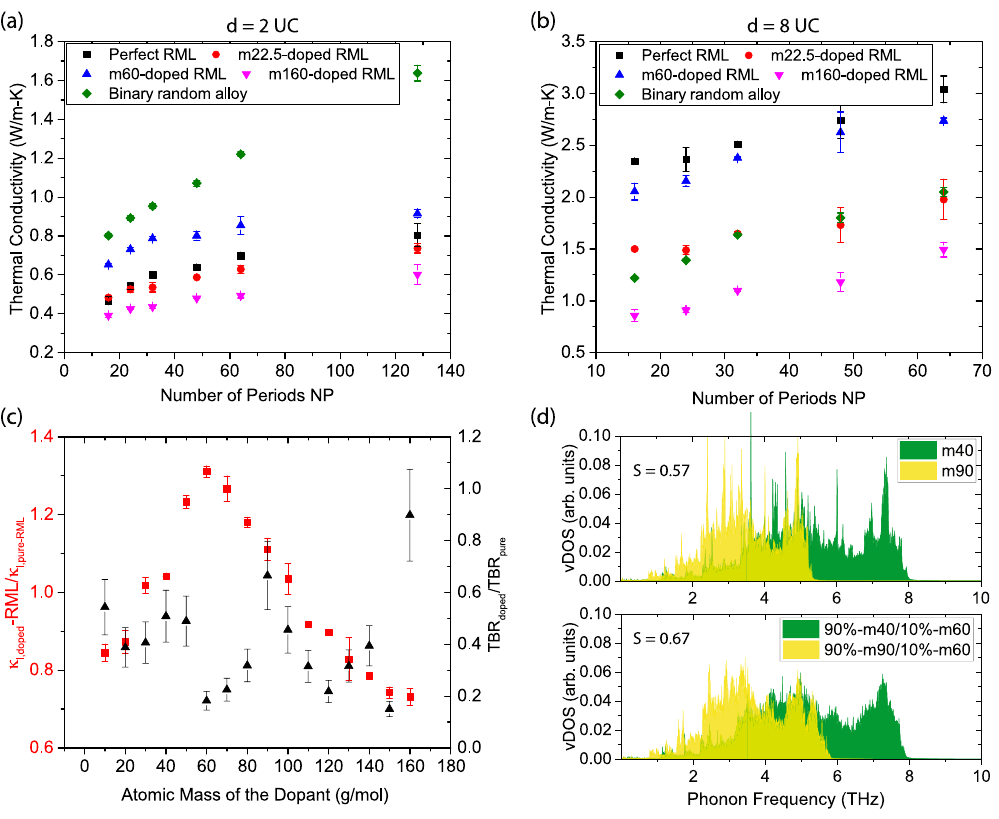
Figure 3. ( a , b ) The lattice thermal conductivity κ l of perfect RMLs, RMLs doped with impurities with an atomic mass of 22.5 g/mol, 60.0 g/mol, or 160.0 g/mol, and binary random alloy of 50% m40/50% m90. The RMLs in ( a ) have an average layer thickness d = 2 UC while those in ( b ) have d = 8 UC. ( c ) Left axis: the relative = 2 UC) with respect to that of pure RMLs. Right axis: the TBR (normalized by the TBR of κ l of doped RMLs ( d the pure m40-m90 interface) between m40 and m90 segments doped with 10% impurities with various atomic mass. ( d ) The vibrational density of states of m40 and m90 elements and those of m40 and m90 crystals doped with 10% m60